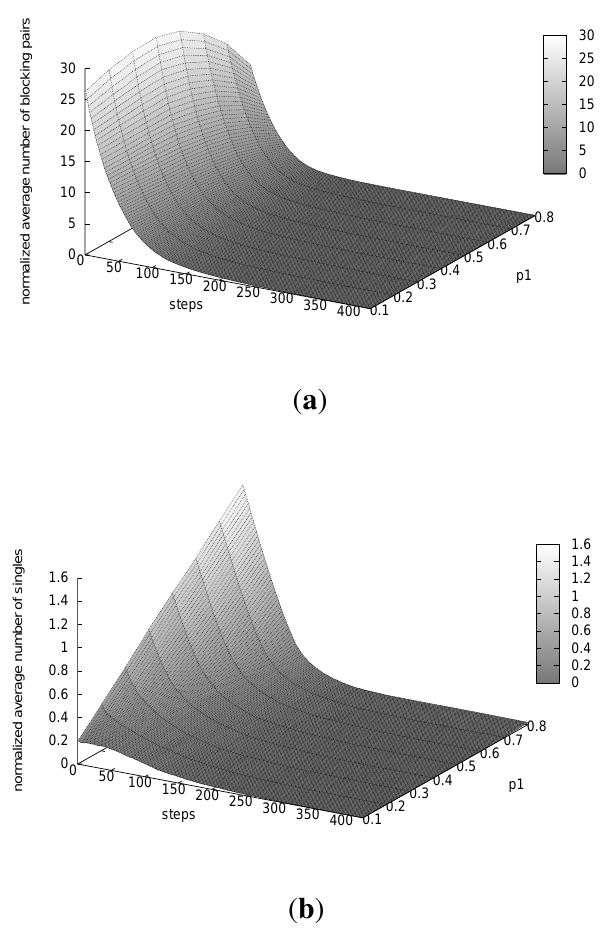
Figure 6. LTIU runtime behavior ( p pairs; ( b ) average normalized number of